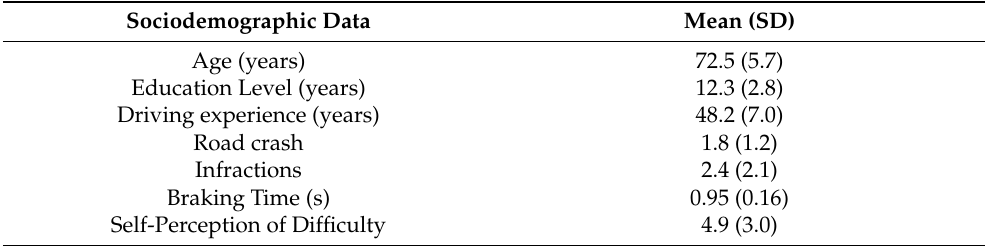
Table 1. Demographic and driving characteristics (n = 100).